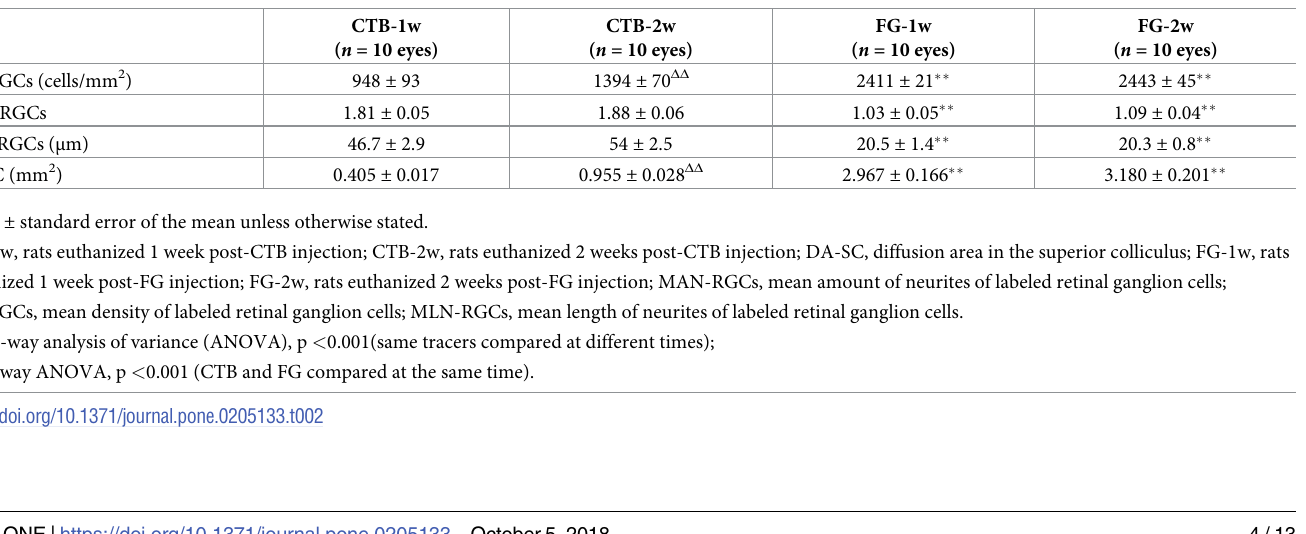
Table 2. Results of retrograde tracing using cholera toxin subunit B (CTB) and Fluorogold(FG) at 1 week and 2 weeks in